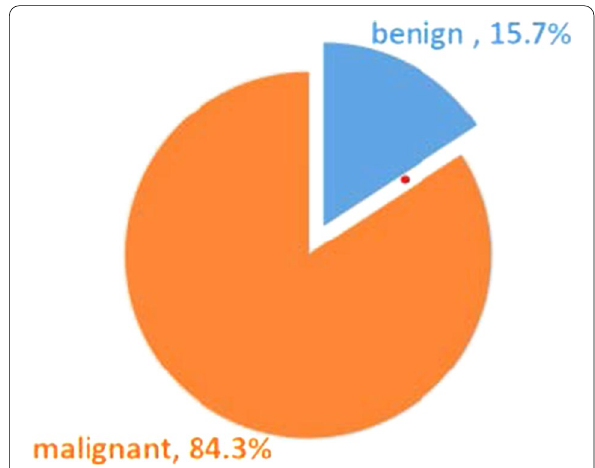
Fig. 1 Pie chart clarify the benign and malignant associated with breast edema